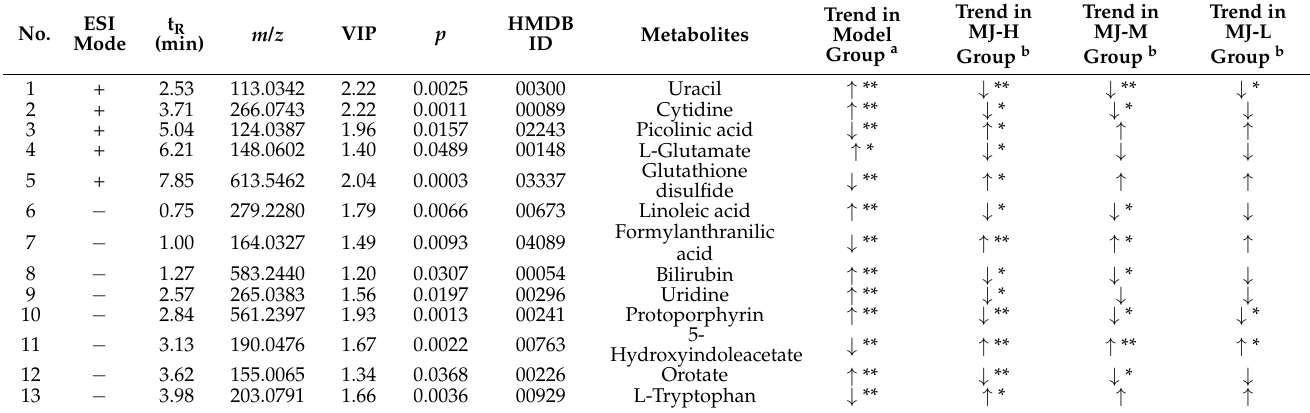
Table 2. Metabolites selected as potential biomarkers characterized in plasma profile and their change trends (n = 6 in each